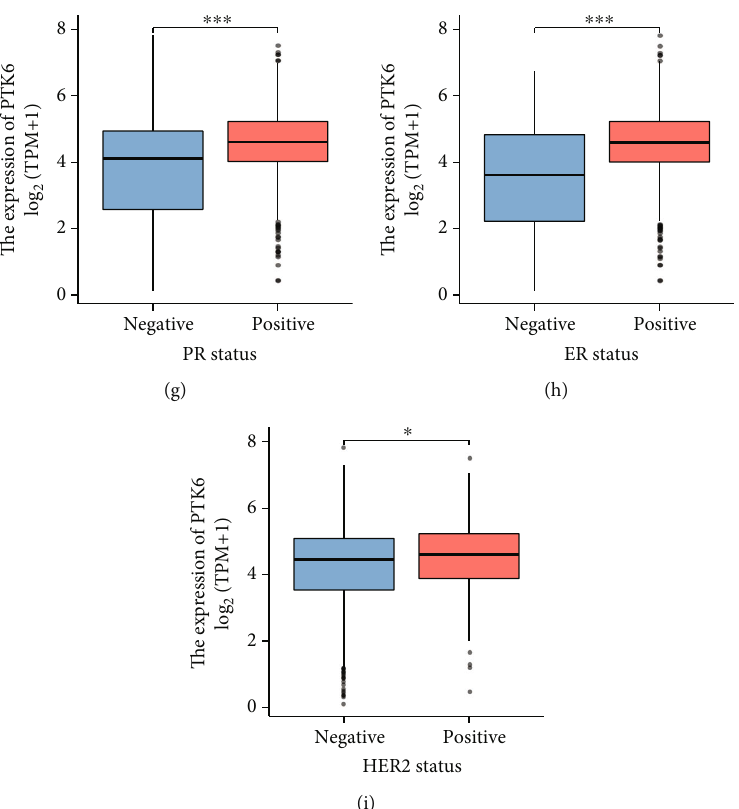
Figure 5: Di ff erential PTK6 expression in various clinicopathological parameters, including (a) age, (b) T stage, (c) M stage, (d) N stage, (e) pathologic stage, (f) histological type, (g) PR status, (h) ER status, and (i) HER2 status. ∗ p < 0 : 05 , ∗∗ p < 0 : 01 , and ∗∗∗ p < 0 : 001